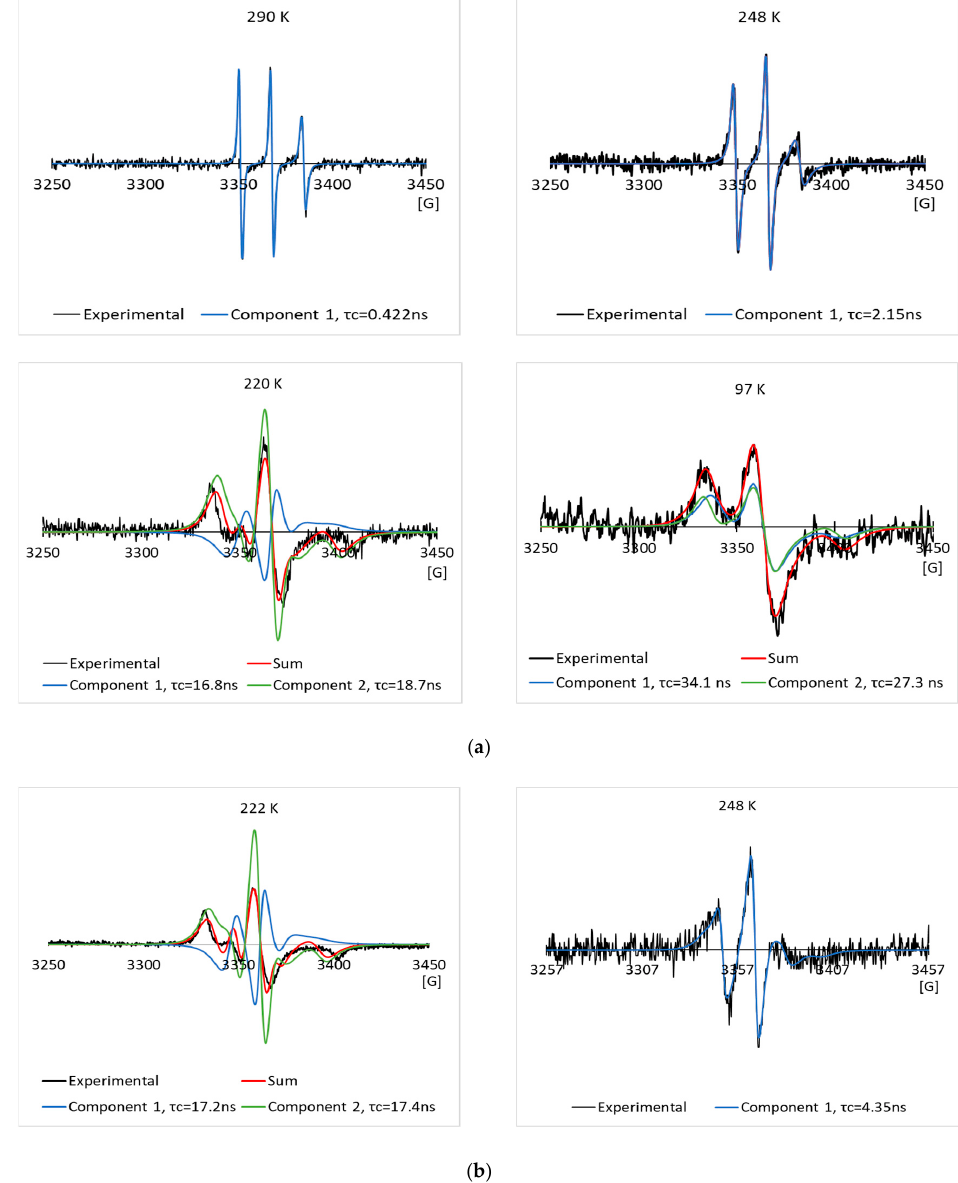
Figure 7. Typical experimental EPR spectra, and their simulated EPR spectra of the 2.0 mg/mL spin labeled A17C in the 5% propylene glycol solution in the freezing process ( a ), and melting process ( b ), respectively.